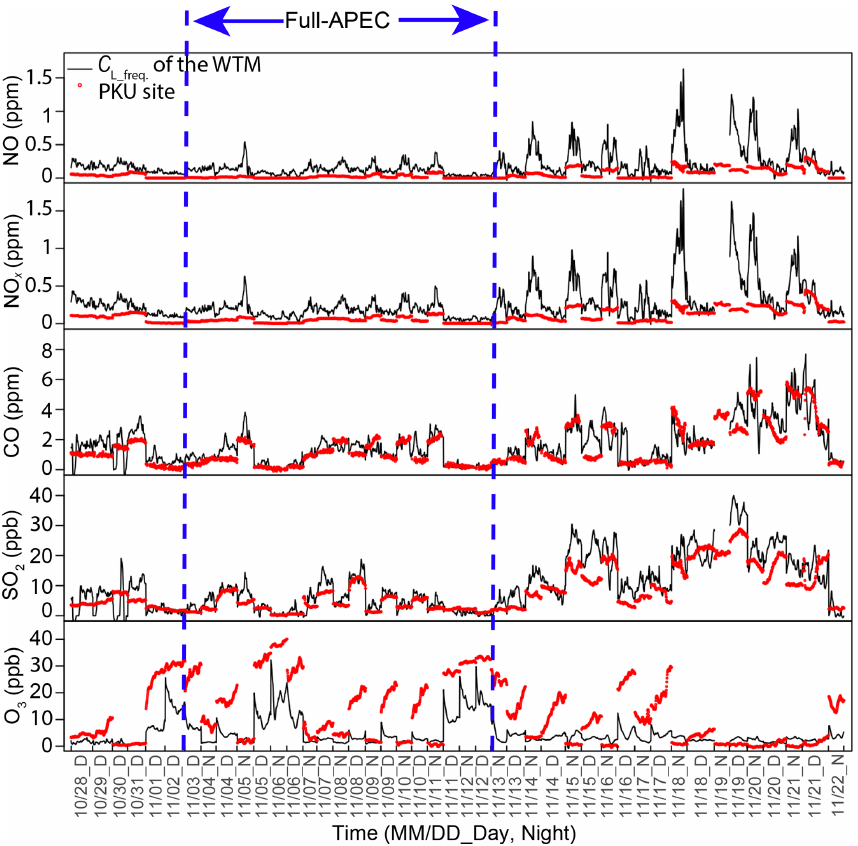
Figure 8. Comparisons between time series of the low-frequency components of the WTM and concentrations observed at the PKU site for NO, NO x , BC, CO, SO 2 , and O 3 . The black lines represent the low-frequency components of the WTM. The red line represents the 1min average concentrations of pollutants observed at the PKU